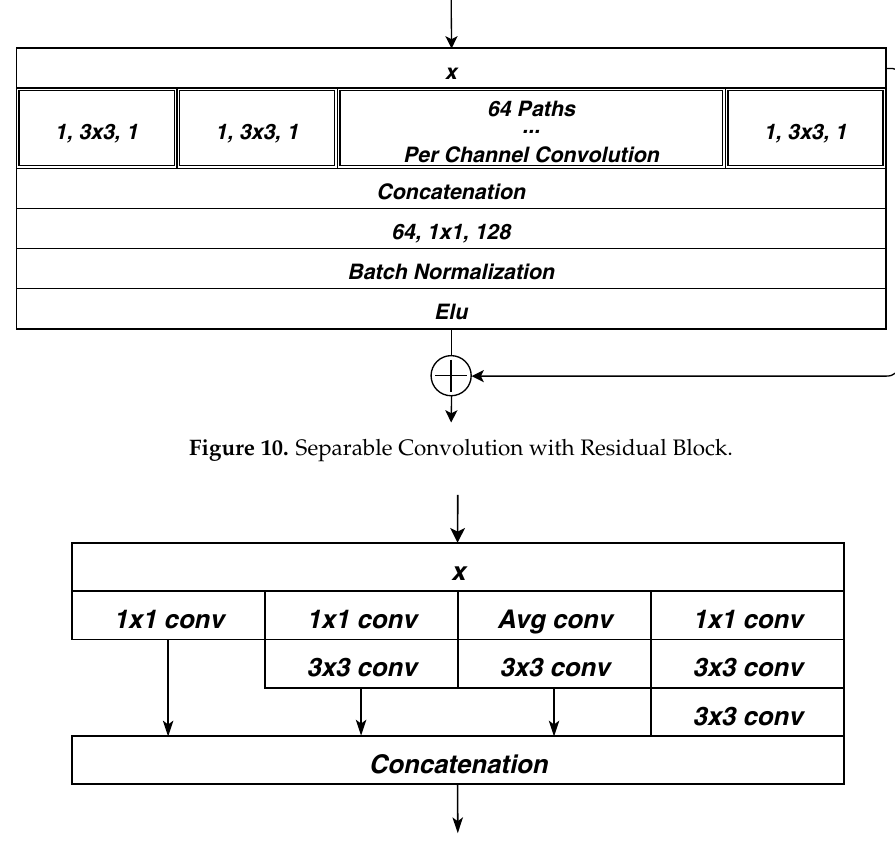
Figure 11. Basic Building Block in Inception